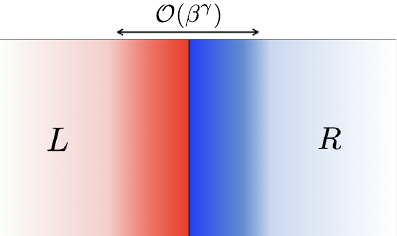
FIG. 1. Schematic depiction of our problem. By decomposing the total system into L and R , we consider the mutual information I ð L ∶ R Þ ρ between L and R . Then, the thermal area law in β ≲ β j ∂ L j ( γ ¼ 1 in the above picture). Ref. [28] gives I ð L ∶ R Þ ρ β We aim to establish a new thermal area law in the form of ≲ β γ j ∂ L j with γ < 1 . In particular, it is a highly I ð L ∶ R Þ ρ β nontrivial and fundamental question to identify the best exponent γ for which the thermal area law holds in generic many-body c systems. Our main result provides the nontrivial upper bound ≤ 2 = 3 of γ c